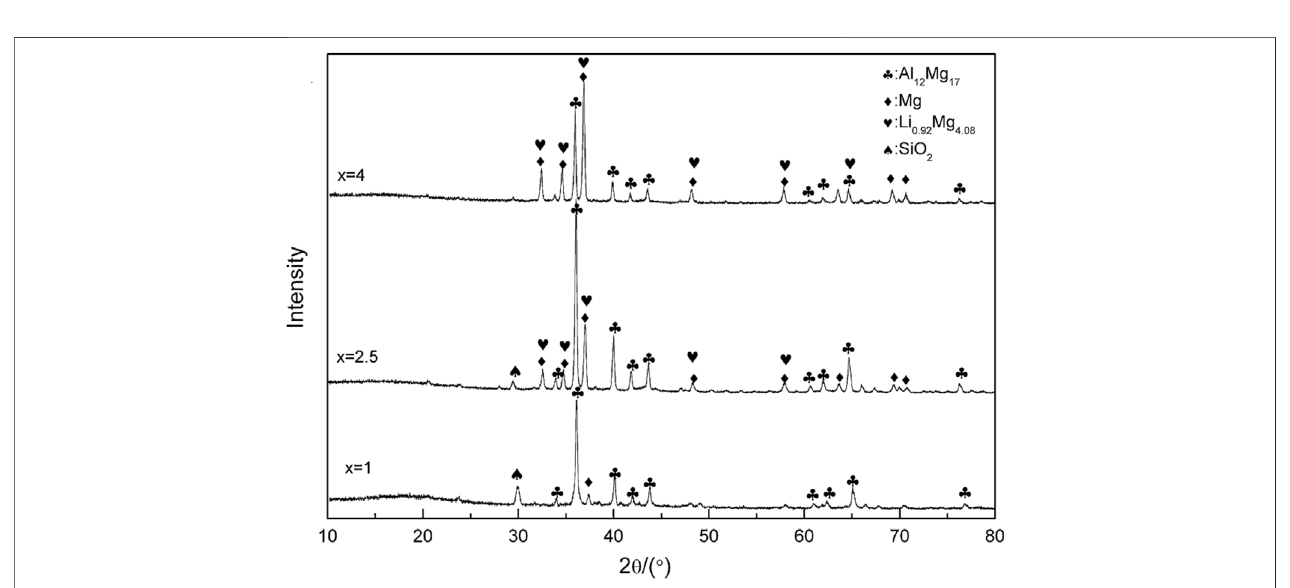
FIGURE 5 | XRD patterns of LiAlH 4 + xMgH 2 (x = 1, 2.5, and 4) after dehydrogenation at 350 ° C (Chen et al., 2010).